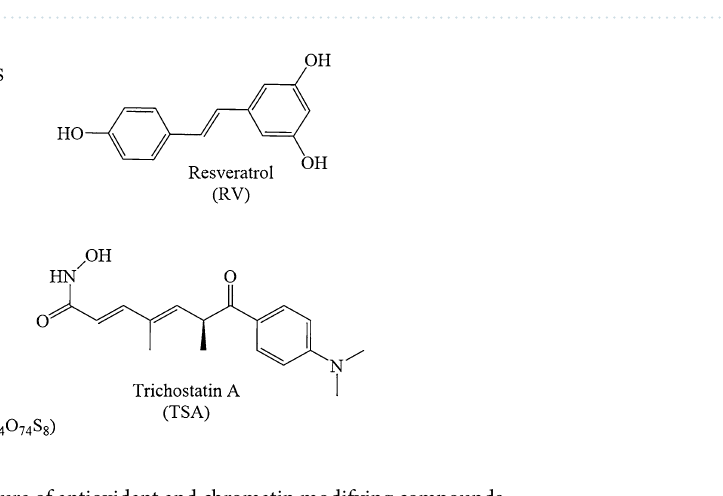
Figure 1. Two murine models of OVA-induced chronic allergic airways timelines. The difference between the prevention (a) and reversal (b) murine OVA-induced chronic allergic airways model timelines.